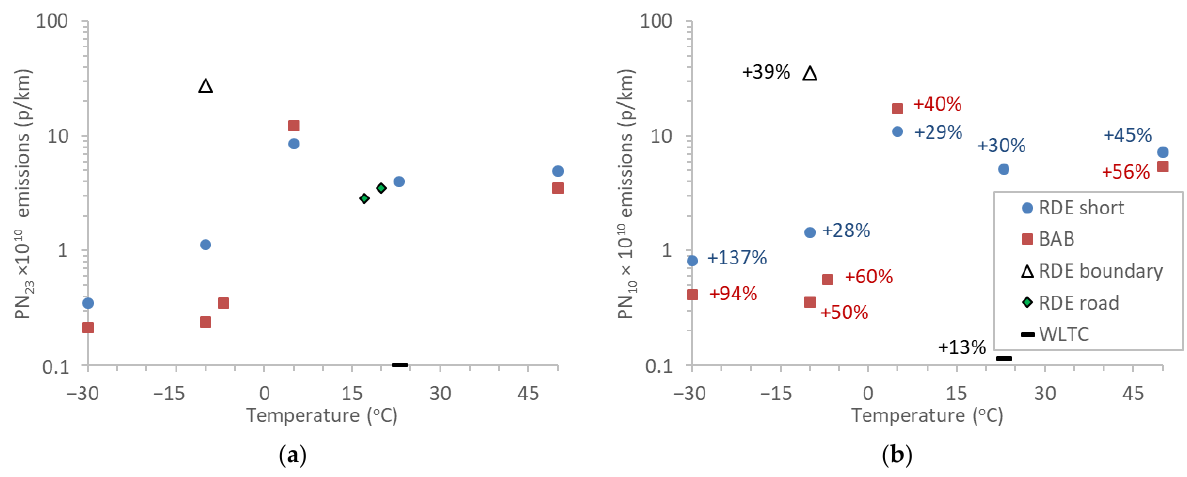
Figure 6. Emissions of motorway cycle (BAB) or motorway parts of the rest cycles (RDE short, RDE boundary, RDE road, WLTC) in function of ambient temperature. The emissions of the extra-high part of the WLTC are also given. ( a ) PN > 23 nm; ( b ) PN > 10 nm. Percentages give the excess particles between 10 nm and 23 nm. RDE = real-driving emissions; WLTC = worldwide harmonized light vehicles test cycle.